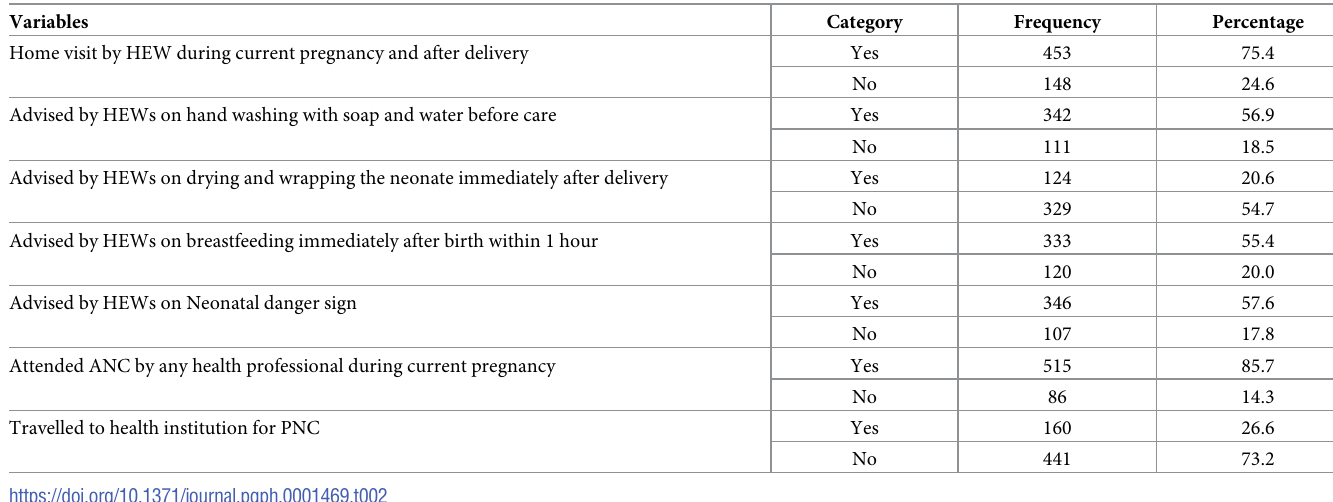
Table 2. Health service utilization among home delivered women, in Guto Gida district, Oromia regional state, Ethiopia, September 2020 (n = 601).